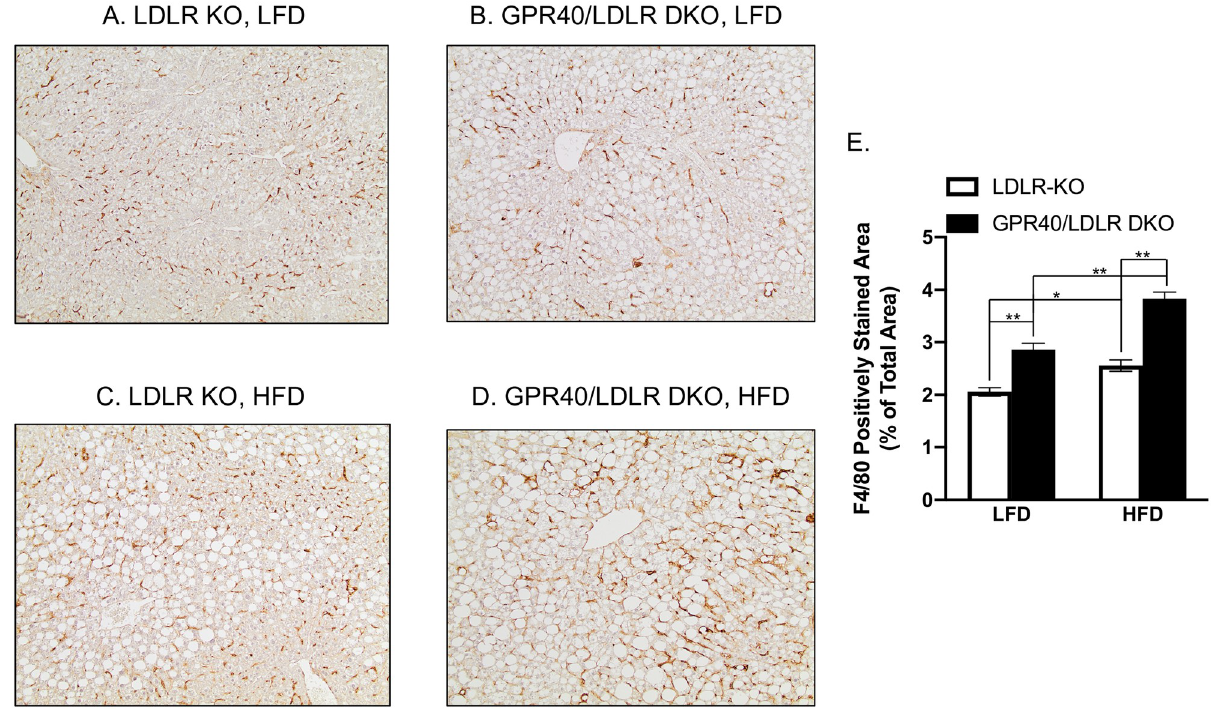
Fig 4. The effect of GPR40 KO on hepatic inflammation in LFD- or HFD-fed LDLR-deficient mice. A–D: Representative images of liver sections with F4/80 immunostaining (magnification: x100). E: The positively stained areas of F4/80 immunostaining were quantified and compared among all groups. The data are presented as means ± SE (n = 6–8). One-way ANOVA and Student’s t test were used for the statistical analysis. � p < 0.05; �� p < 0.01. LFD, low-fat diet; HFD, high-fat diet; KO, knockout; DKO, double knockout.